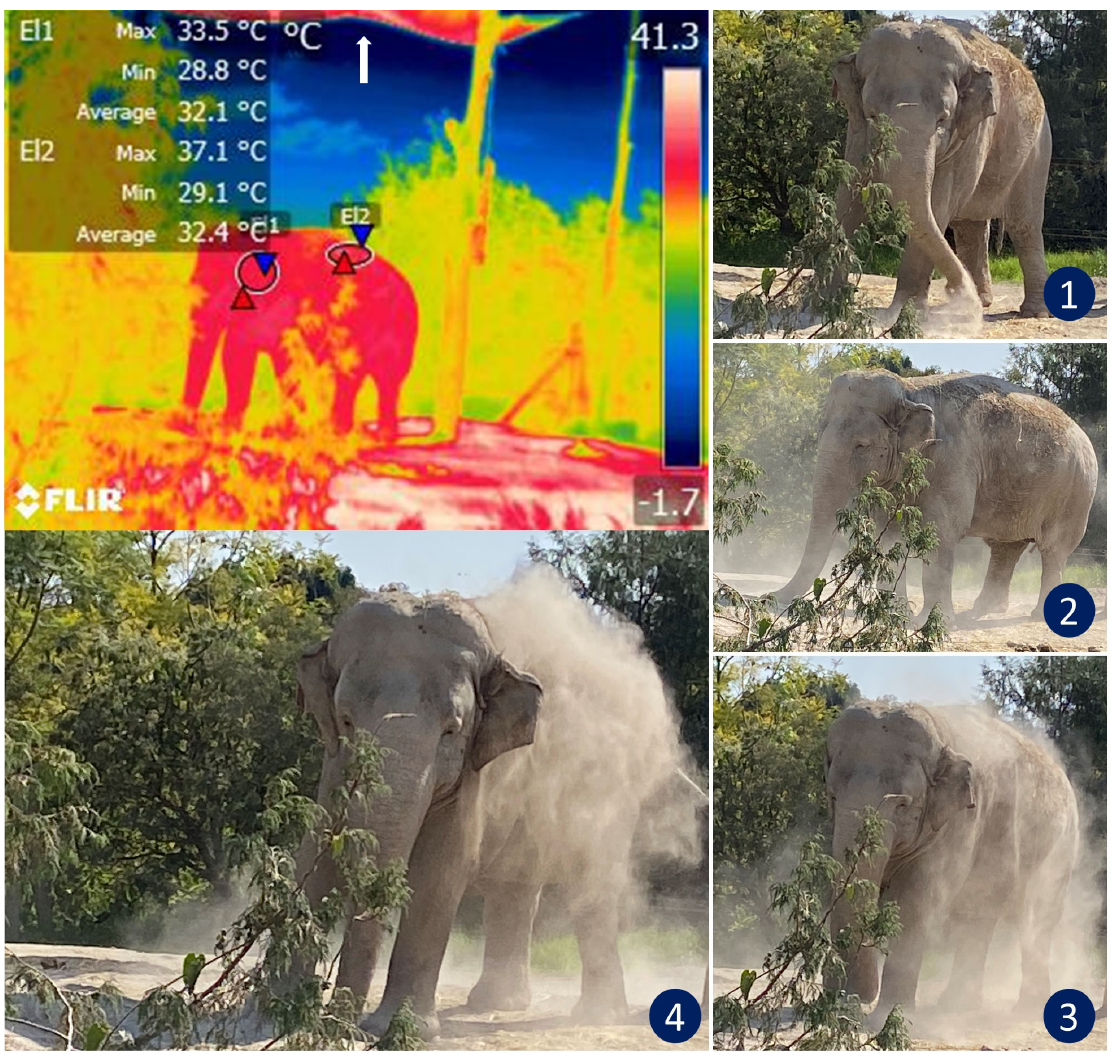
Figure 6. Thermoregulatory behavior in an African elephant ( Loxodonta africana ) under heat stress. The sequence of digital images shows dustbathing in an elephant exposed to high temperatures that triggered thermal imbalance (see images 1, 2, 3, and 4). The radiometric image shows the average temperature of the auricular (El1) and dorsal (El2) thermal windows. Under normal conditions, the ear temperature in elephants oscillates between 25 and 31 ◦ C. However, the thermal image shows a temperature in the auricular region as high as 33.5 ◦ C. IRT imaging reveals that although the animal covers its back with dust to thermoregulate, this behavior might be insufficient to achieve thermostability in this environment because the maximum temperature of the dorsum was 37.1 ◦ C. Although the enclosure has a shade mesh as a roof to reduce direct sunlight (white arrow), it is not enough to reduce thermal stress in this species. (Radiometric images and photographs by the au ‐ thors).